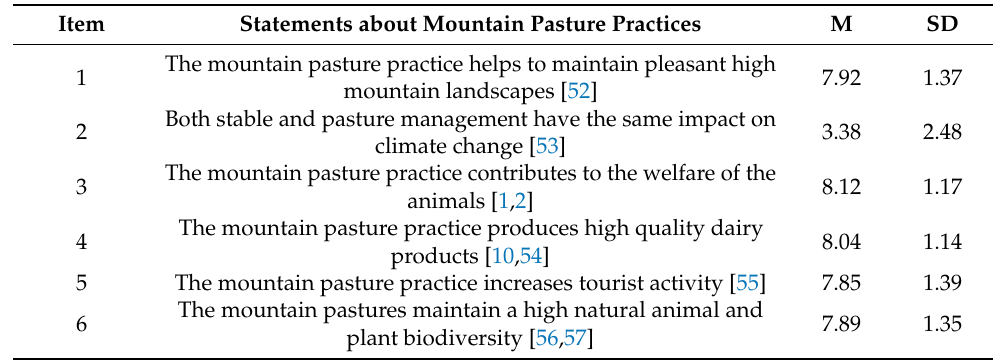
Table 3. Mean (M) and Standard Deviation (SD) values for each statement of the Mountain Pasture Practice